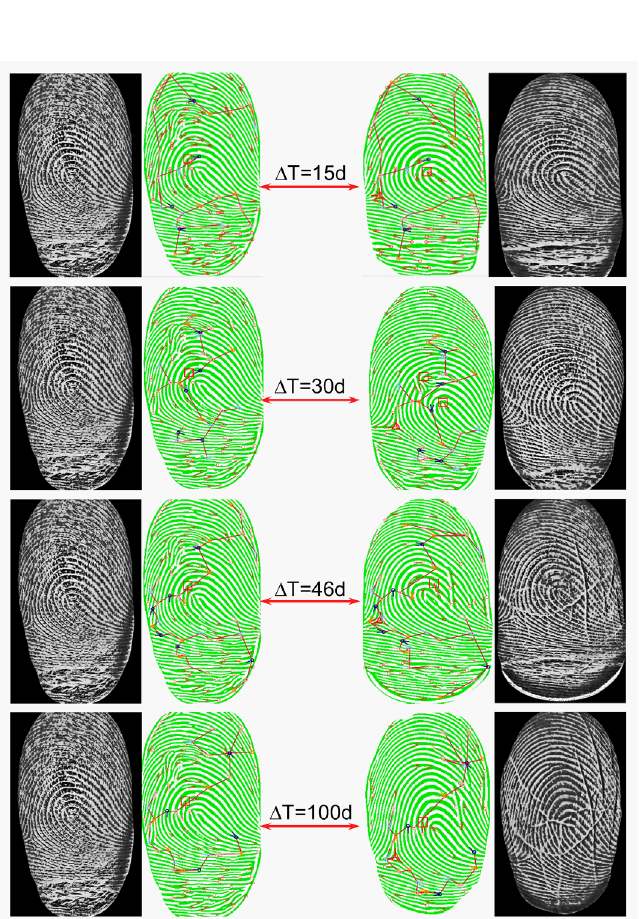
Figure 20. Persistent matching of a single infant over multiple